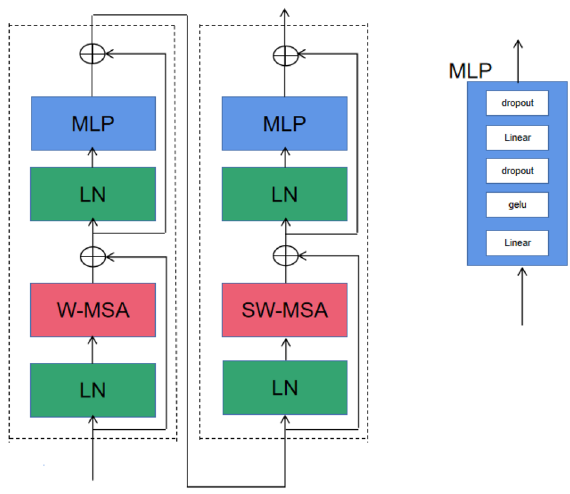
Figure 7. Block of swin transformer 8 used in our paper, where LN is layer normalization